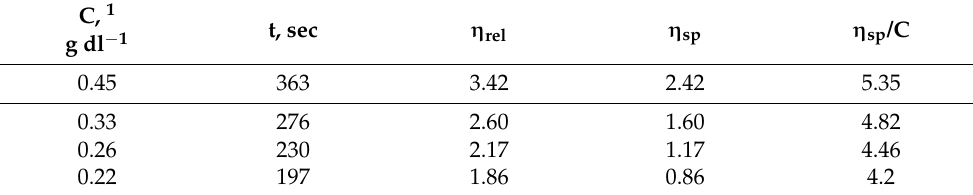
Table A1. Hydrodynamic properties of Ch2-LMw chitosan